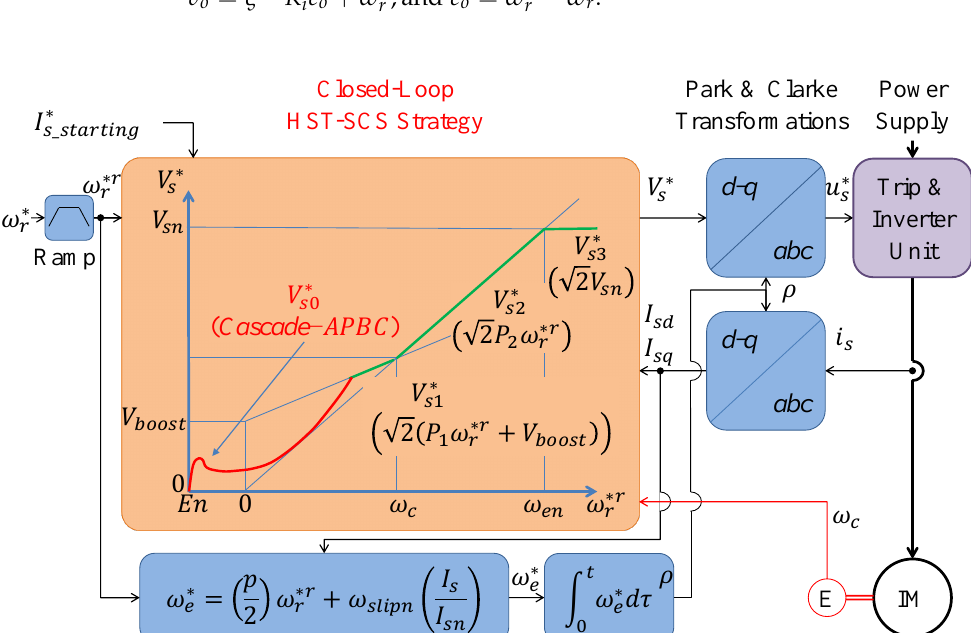
Figure 3. Block diagram of the proposed CL HST-SCS for IM, remarking the differences in red. Here, the adaptive controller parameters are θ i ∈ (cid:60) 6 and θ o ∈ (cid:60) 3 . The fixed-gains are Γ i , Γ o ∈ (cid:60) + depending on the design parameter (cid:101) o , (cid:101) i ∈ [ 0.1, 10 ] . The normalized information vectors are ¯ Ω i ∈ (cid:60) 6 and ¯ Ω o ∈ (cid:60) 3 . The CL HST-SCS considers that the IM dynamical d-q model has the form of (9). Here, the outputs are y i ( t ) = I sd , y o ( t ) = ω r ∈ (cid:60) , and the control inputs are u i ( t ) = (cid:2) (cid:3) ∈ (cid:60) 5 V sd , u o ( t ) = | I s | 2 ∈ (cid:60) . The unknown parameters are α = A 1 upper 1 A 2 upper , β = 1 , σ L s (cid:104) (cid:105) 1 − b p ∈ (cid:60) 2 , and δ = | jL m | 2 . Additionally, the known nonlinear functions T l γ = Rr J J + jL r ω slip (cid:2) (cid:3) T ∈ (cid:60) 5 I sd I sq ω ∗ I sq p ω r I sq p ω r I sq are a ( y ) = , b ( y ) = 1, c = [ ω r 1 ] T ∈ (cid:60) 2 , and d = 3 p . e 2 2 2 (cid:2) (cid:3) T ∈ (cid:60) 3 I sq Φ rd Φ rq Moreover, the internal dynamics are z ( t ) = , defined as